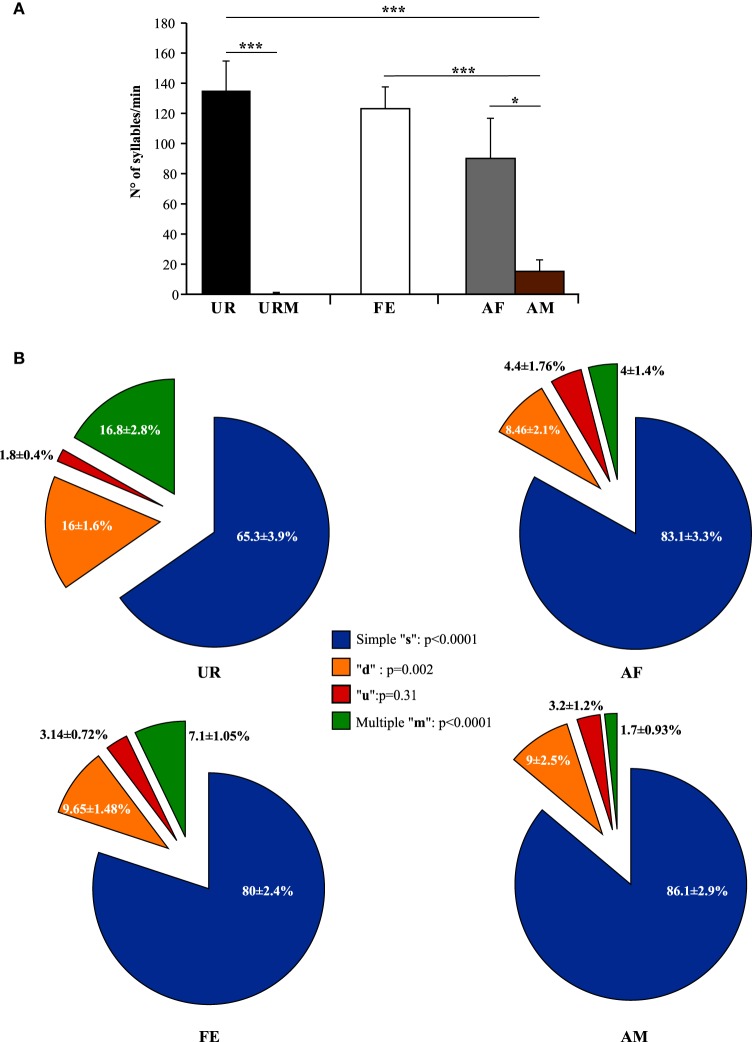
Number of syllables emitted and repertoire across conditions. (A) Call rate (number of USVs per minute). Data are presented as mean ± SEM (n = 12 males). *p < 0.03, ***p < 0.0001 for post-hoc Student's paired t-test after Benjamini and Hochberg correction. (B) Repertoire compositions in urine (UR), anesthetized female (AF), live female (FE), anesthetized male (AM) conditions. Central statistics refer to the repeated measure ANOVA across contexts for a given syllable.